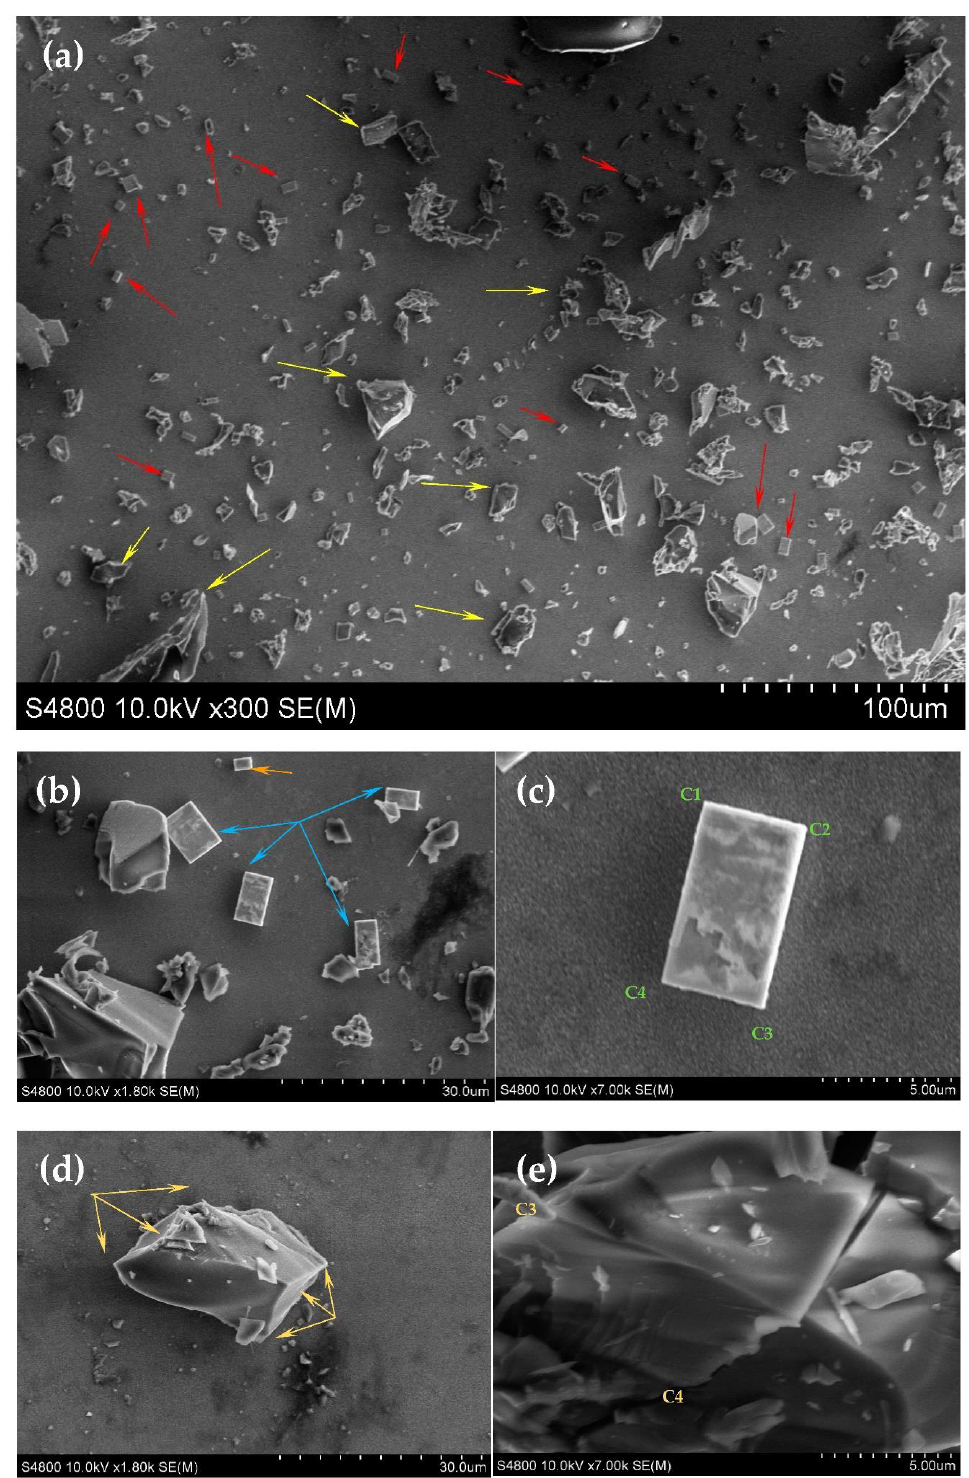
Figure 3. SEM images of Co-Cu-Fe-Zn oxide films obtained by electrodeposition in basic medium (pH-13) at −1.5 V. ( a ) SEM micrograph taken at 100 μ m, arrows showing random distribution of cubic and tetragonal particles; ( b ) SEM micrograph of cubic particles magnified at 30 μ m; ( c ) SEM micrograph of cubic particles magnified at 5 μ m; ( d ) SEM micrograph of tetragonal-shaped particles magnified at 30 μ m as indicated by arrows; ( e ) SEM micrograph of tetragonal-shaped particles magnified at 5 μ m.